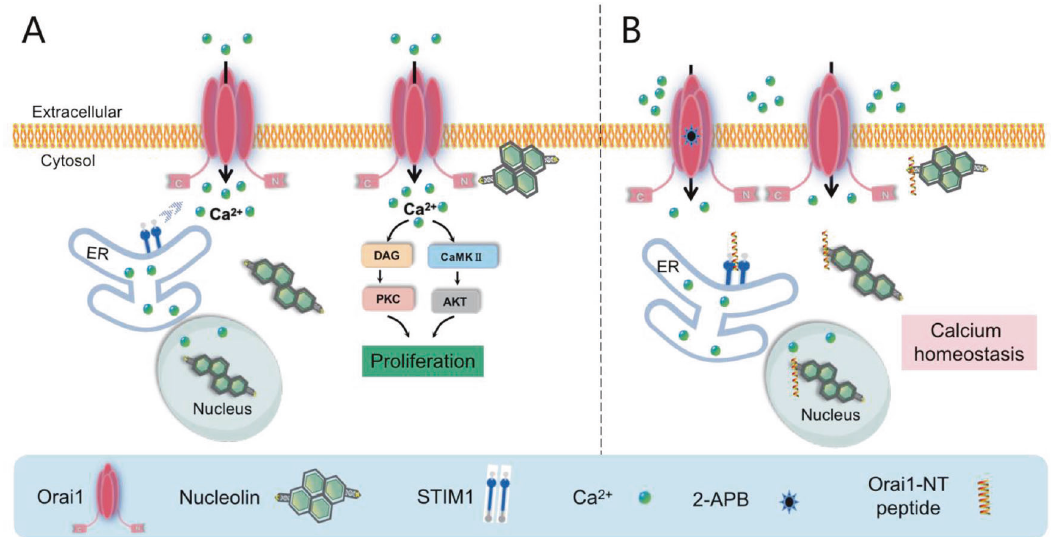
Fig. 7 Schematic model for the activation of Orai1 by Nucleolin promotion the proliferation of breast cancer cells. A NCL proteins shuttle from nucleolus to cytoplasm and cell membrane, and then interact with calcium channel Orai1 at the plasma membrane via the C-terminal domain, which results in activation of Orai1 channel and calcium entry, eventually leading to activation of calcium related signaling pathways and promotion breast cancer cell proliferation. B Orai1 inhibitor 2-APB and synthesized Orai1-NT peptides blocking NCL/Orai1 interaction could inhibit NCL-meditated calcium in fl ux, partially restore intracellular calcium homeostasis and inhibit the proliferation of breast cancer